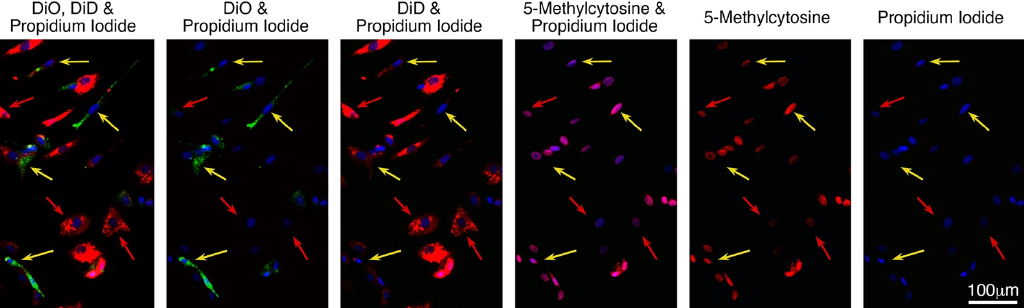
Figure 6. Photomicrographs from experiment ‘p’ of fibroblasts (pre-labelled with DiD) co-cultured for 24 h with SAOS-2 (pre-labelled with DiO), with co-cultures then further labelled with propidium iodide for DNA and by fluorescence immunohistochemistry for 5mc. Channels for DiO, DiD, 5mc and propidium iodide are shown. DiD and DiO seen previously (Figure 1), with fibroblasts (red arrows) distinguishable from SAOS-2 (yellow arrows), which in this particular visual field all re- ceived at least some fluorescent contents from fibroblasts. While the difference in propidium iodide fluorescence between fibroblasts and SAOS-2 seen in control cultures appeared maintained (Sup- plementary Materials Figures S10 and S11), co-cultured fibroblasts seemed to have less intense 5mc fluorescence compared with fibroblasts cultured in isolation (Supplementary Materials Figure S10).